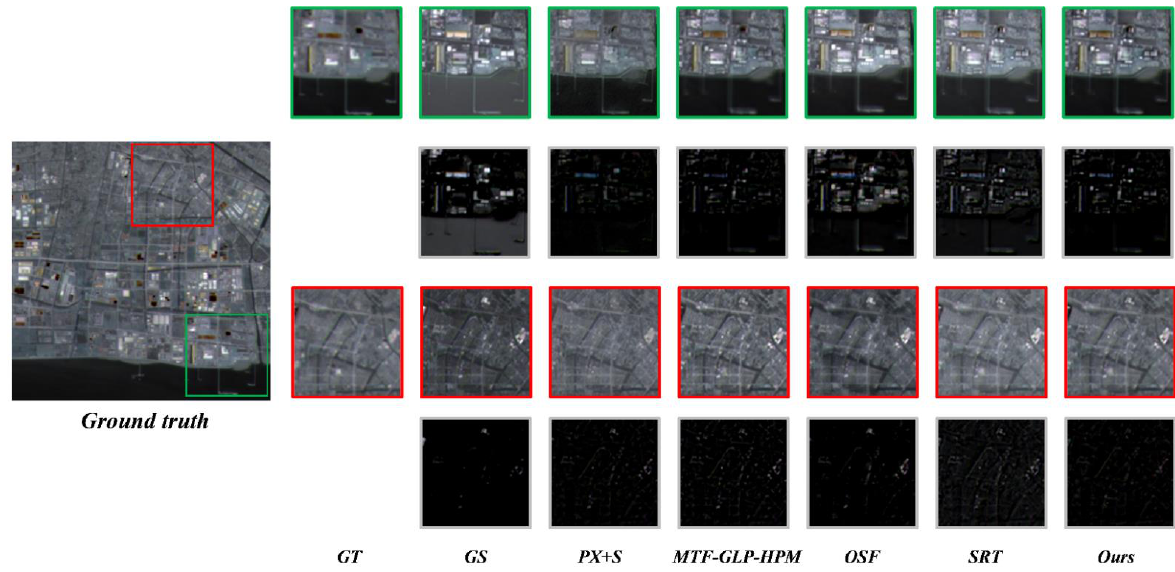
Figure 2. Comparison of fusion results of different algorithms on simulation data (the original image was taken in Shanghai on 8 April 2022; scene: port).